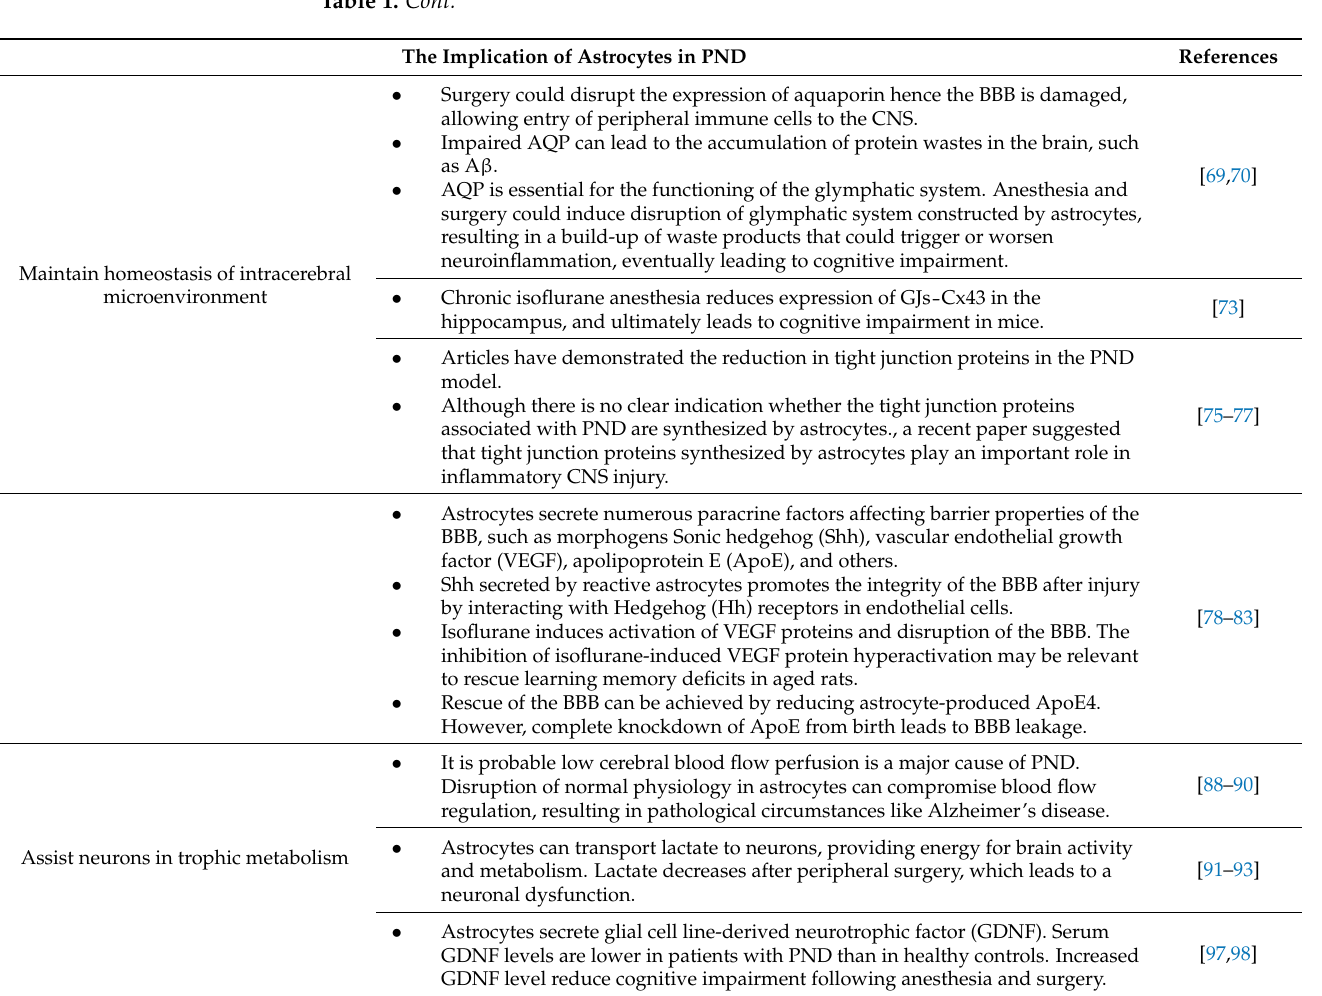
Table 1. Cont. The Implication of Astrocytes in